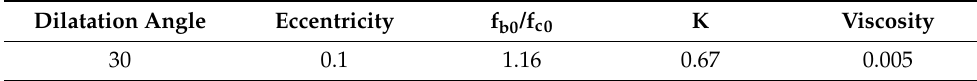
Table 6. Energy dissipation index of the specimens.